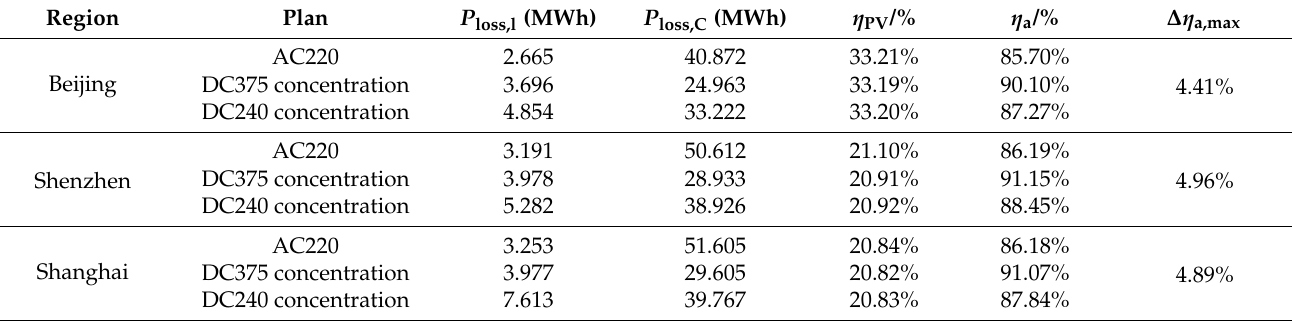
Table A5. Comparison of energy efficiency of residential buildings with different topologies in three